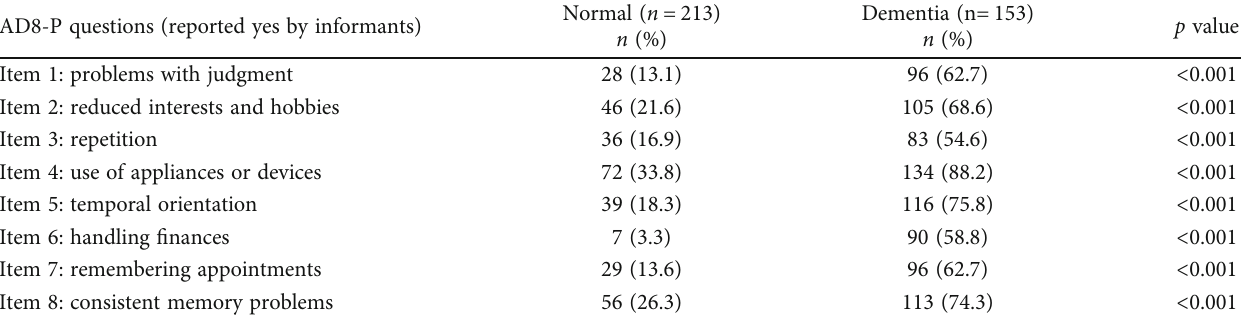
Table 2: Comparison between the groups of older persons with normal cognition and dementia for each item of the AD8-P. AD8-P questions (reported yes by informants)